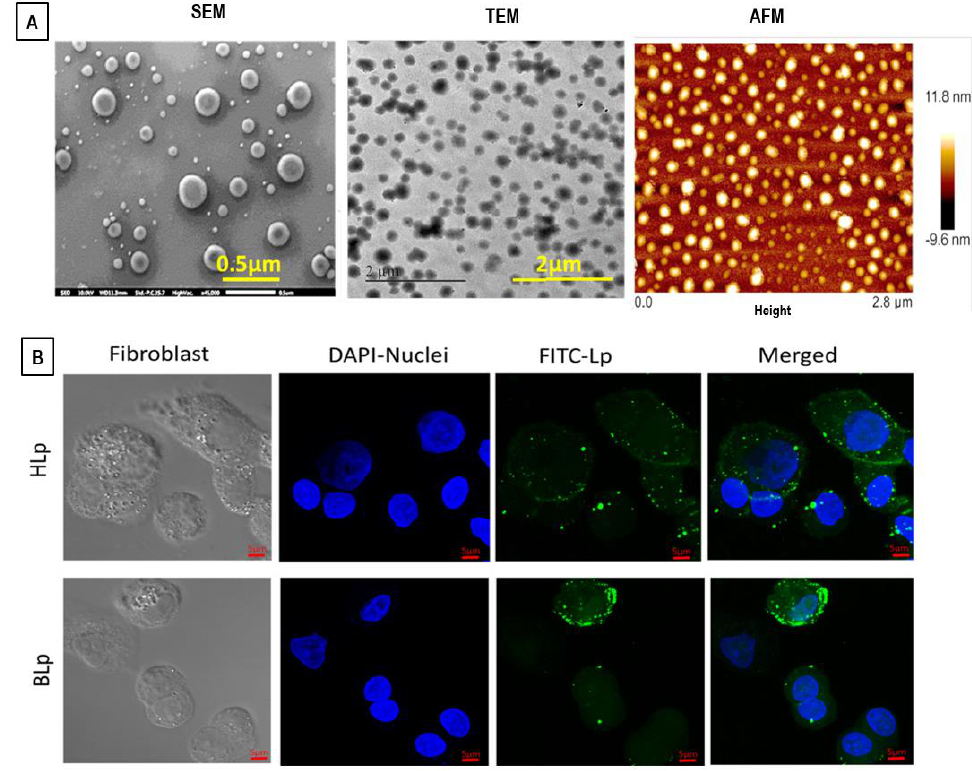
Figure 18. ( A ) Images of heparin-loaded liposomes (HLp), obtained by means of the SEM, TEM, and AFM techniques. ( B ) Confocal laser scanning microscopy images of cellular uptake of HLd (top) and the blank liposomes (BLp) (bottom) by fibroblast cell lines after 3 h of incubation. Blue (DAPI): nucleus; green (fluorescent HLp). Adapted with permission from Vaghasiya et al. [181], Copyright 2019 American Chemical Society.